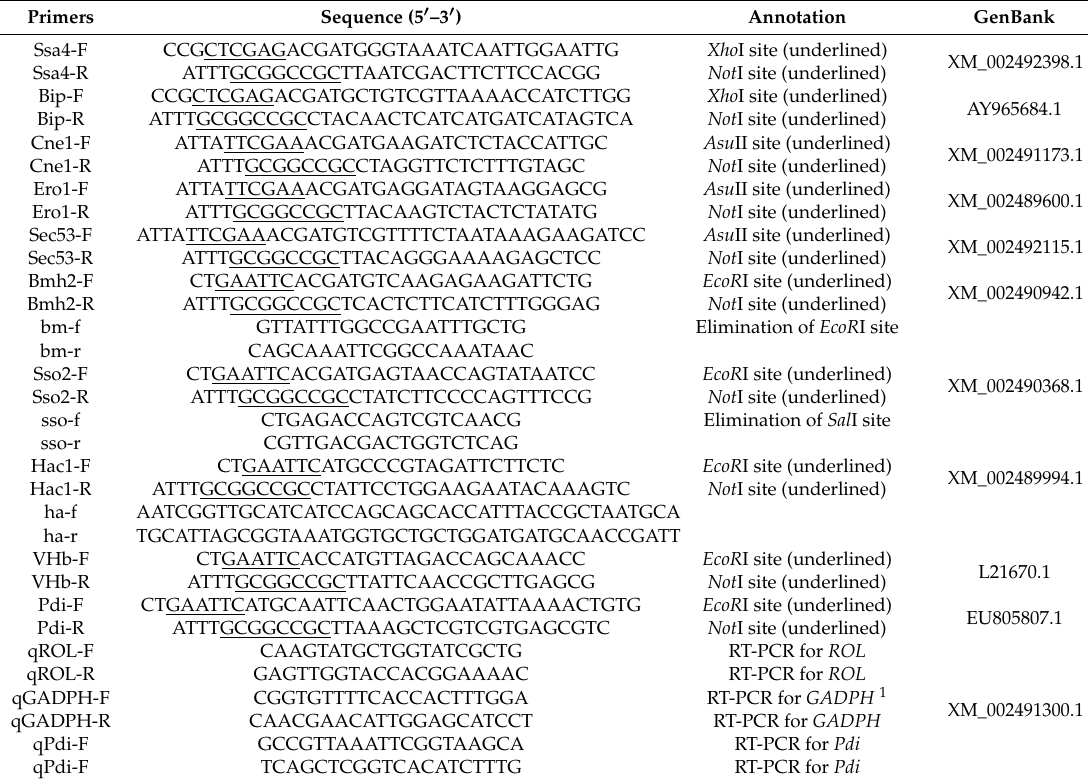
Table 3. Primers used for PCR in this